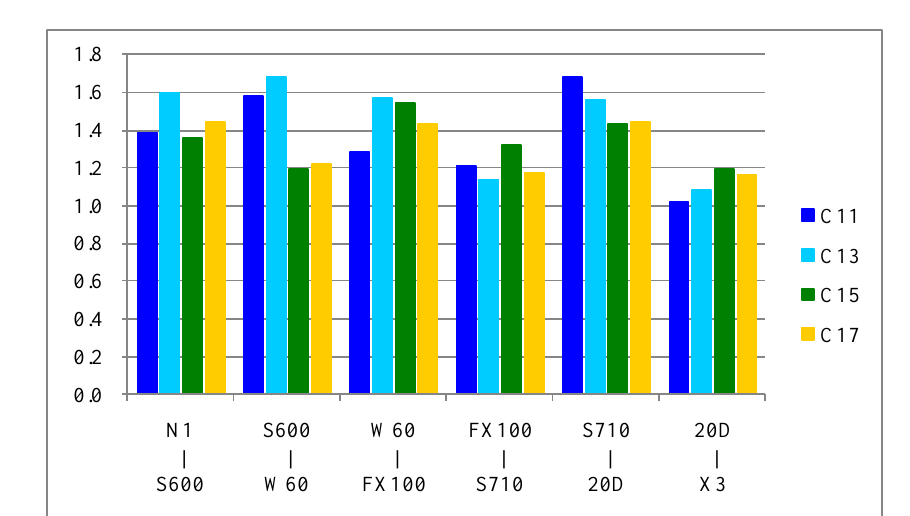
Figure 5. Normalized